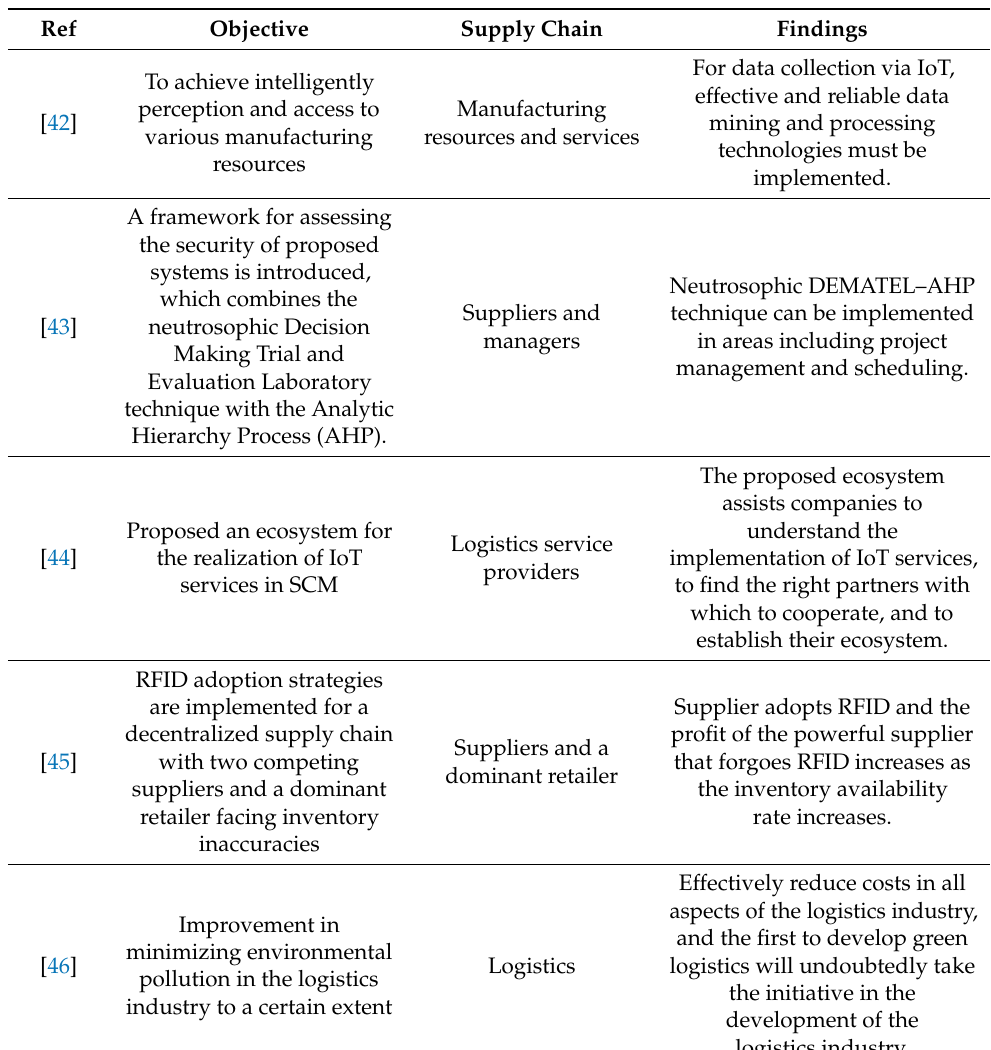
Figure 6. Application of cloud computing in sustainable SCM. Table 1. IoT for sustainable SCM.